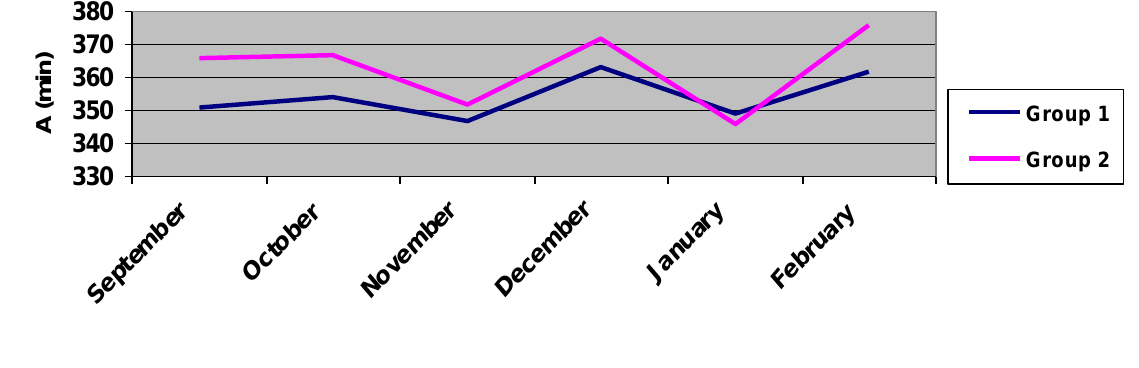
Fig. 1. Data on the level of MA of students: 1 - group number 1; 2 - group number 2; A - daily physical activity